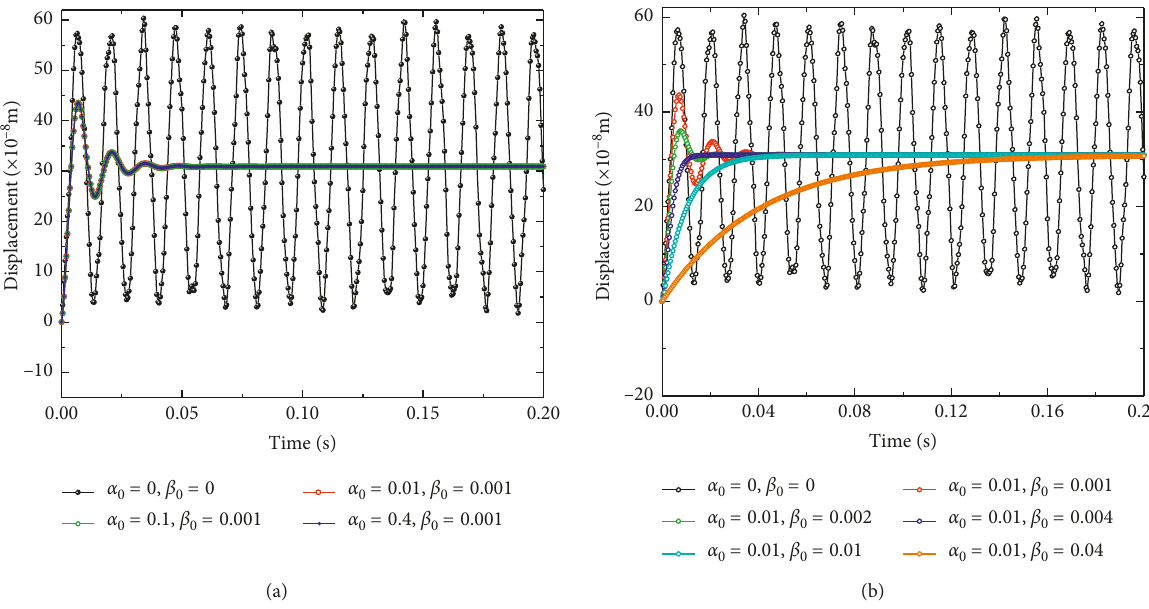
Figure 17: Effect of Rayleigh damping coefficient on transient response of stiffened square plate with SCSC case ( q coefficient α . (b) Stiffness damping coefficient β 0